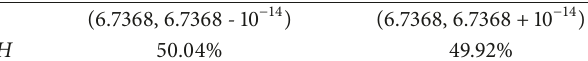
Table 7: The difference between generated binary sequences with different 𝑧 0 .